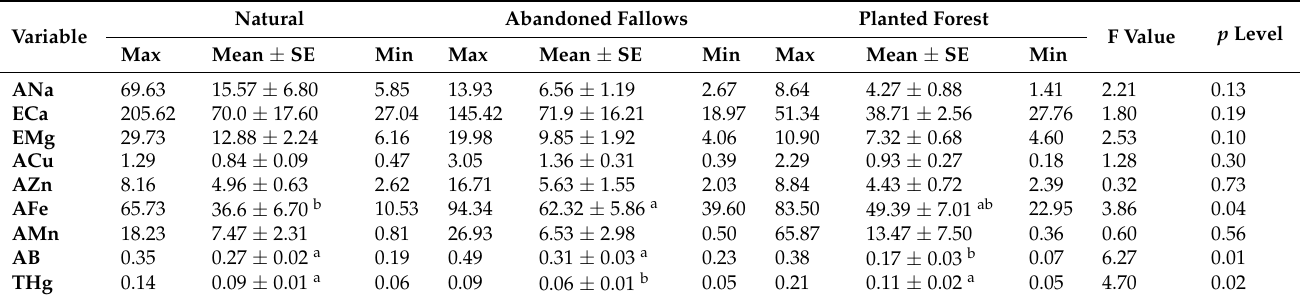
Table 5. Soil mineral concentrations from plots in natural forest, abandoned fallows and planted forest.